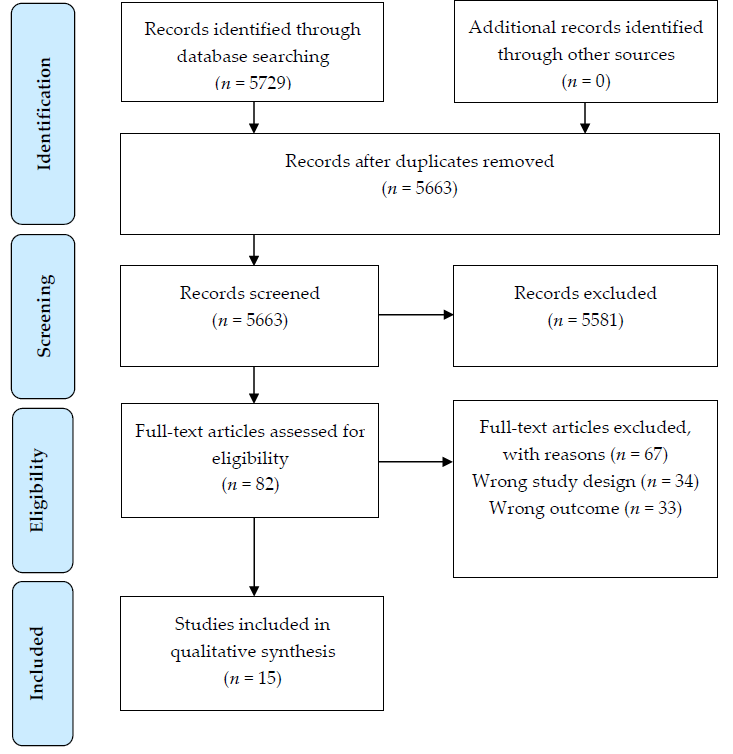
Figure 1. PRISMA [19] flow diagram of article identification retrieval and inclusion for the systematic review.